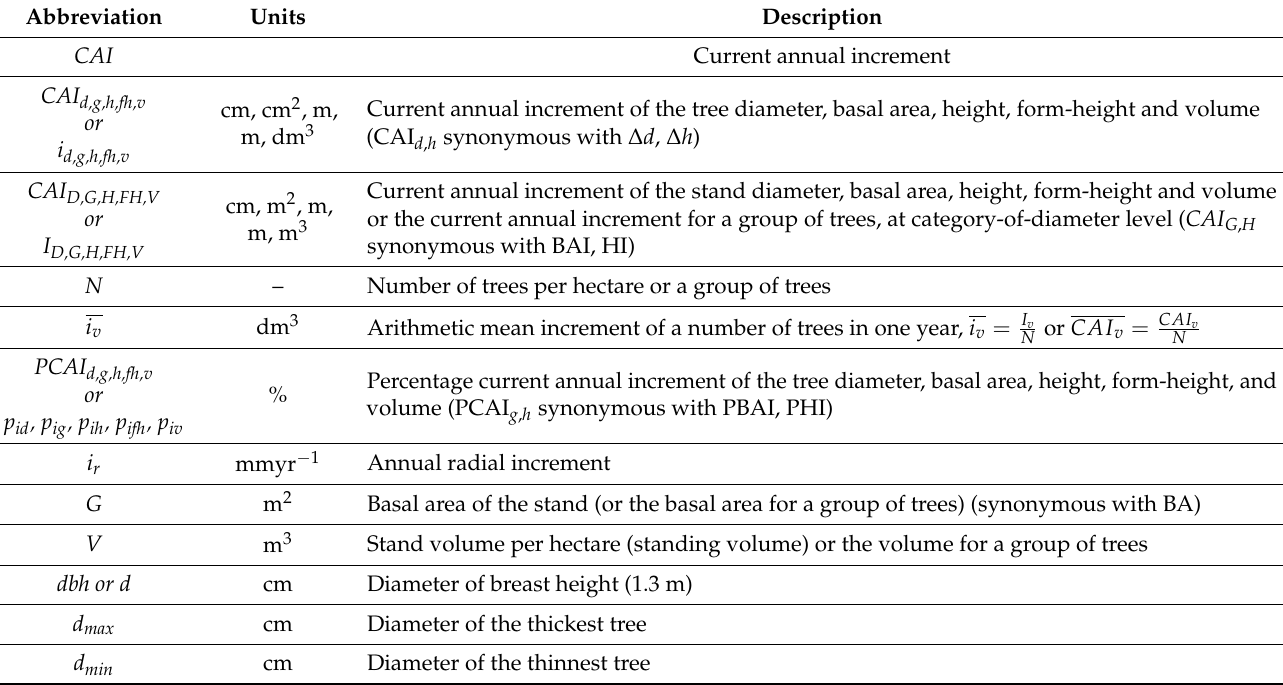
Table 1. Abbreviations of variables